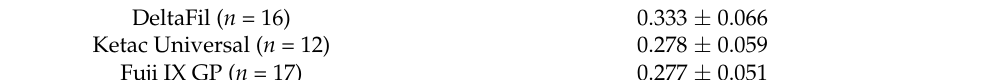
Table 3. Mean fracture toughness of the investigated GICs measured using a notchless triangular prism testing rig.